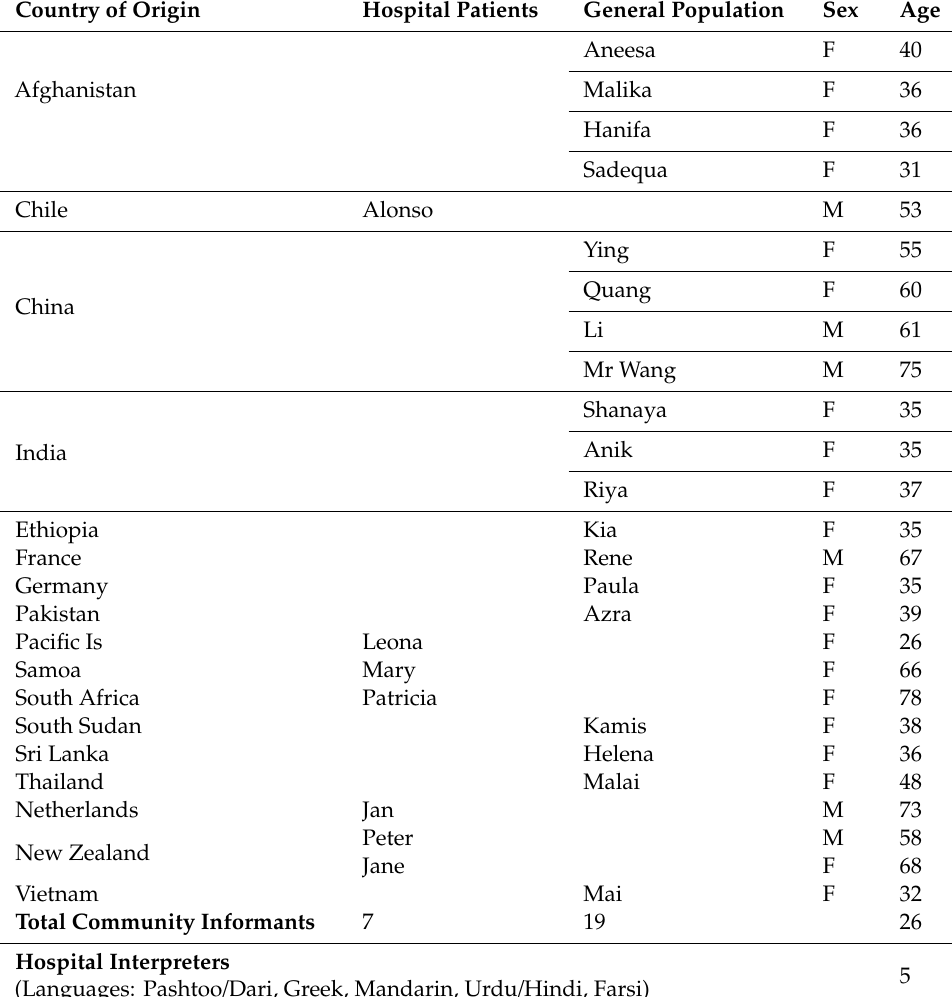
Table 2. Country of origin, sex and age of informants and interpreter